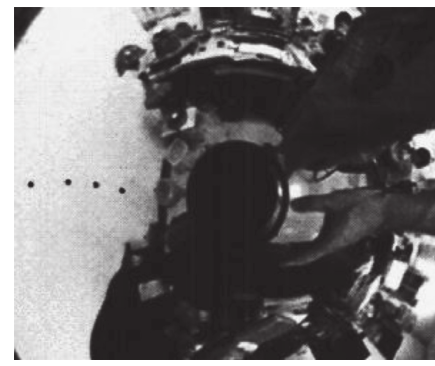
Figure 7: Experimental environment for incident angle verification.